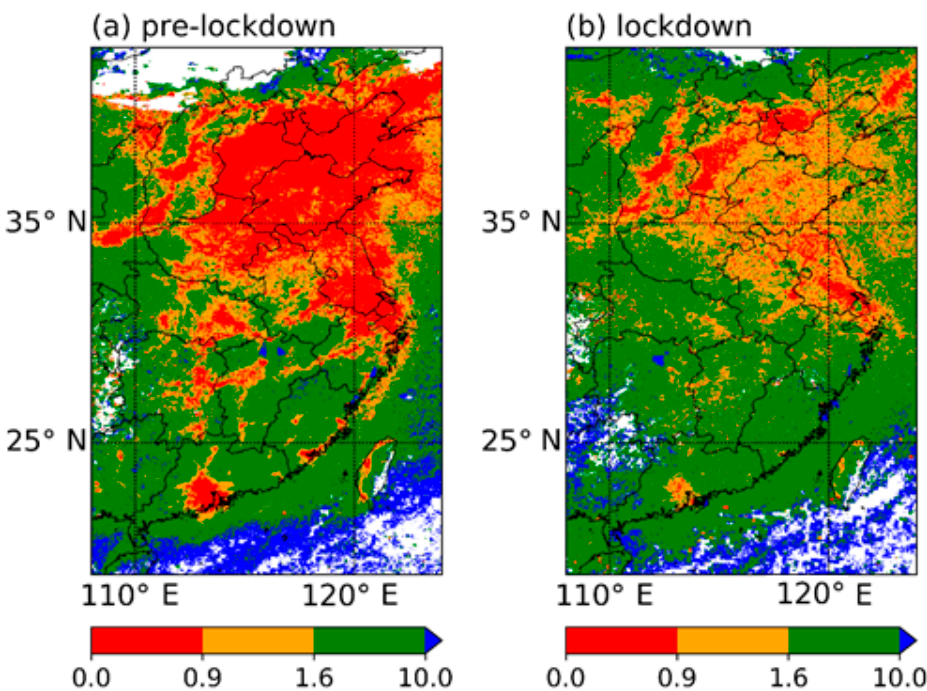
Figure 4. The ratio of HCHO and NO 2 concentrations observed by TROPOspheric Monitoring Instrument (TROPOMI) during ( a ) pre-lockdown and ( b ) lockdown periods in 2020 (HCHO/NO2 < 0.9 indicates NOx-saturated; HCHO/NO2 > 1.6 indicates NOx-limited; 0.9 < HCHO/NO2 < 1.6 indicates transitional